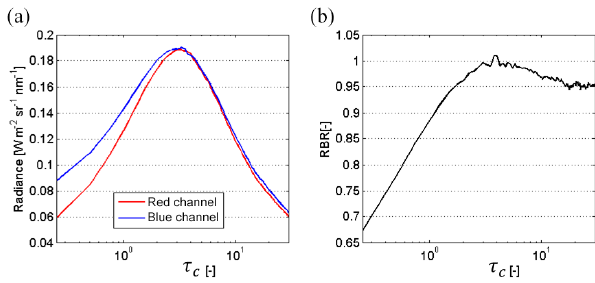
Figure 8. Red and blue channel radiance (a) and RBR (b) vs. τ c for ϑ s of 45 ◦ , θ 0 of 60 ◦ , and ϑ z of 45 ◦